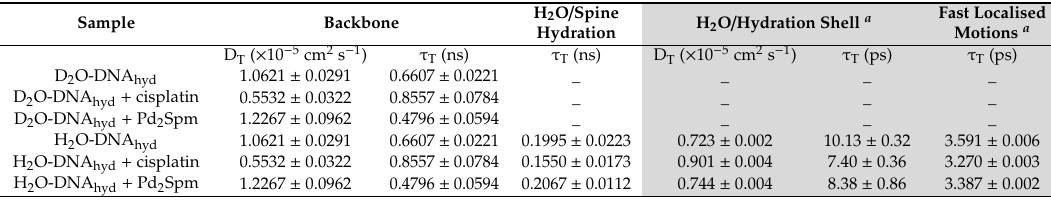
Table 1. Translational di ff usion coe ffi cients (D T ) and relaxation times ( τ T ) of water for untreated and Pd 2 Spm- and cisplatin-treated (at 8 µ M) D 2 O-DNA hyd and H 2 O-DNA hyd (at 298 K) for the dynamics of DNA’s backbone (Q-dependent) and the water motions within the spine of hydration (Q-independent). The translational di ff usion coe ffi cients and relaxation times of hydration water and fast localised motions in the picosecond timescale, formerly obtained for these systems, are also shown (shaded